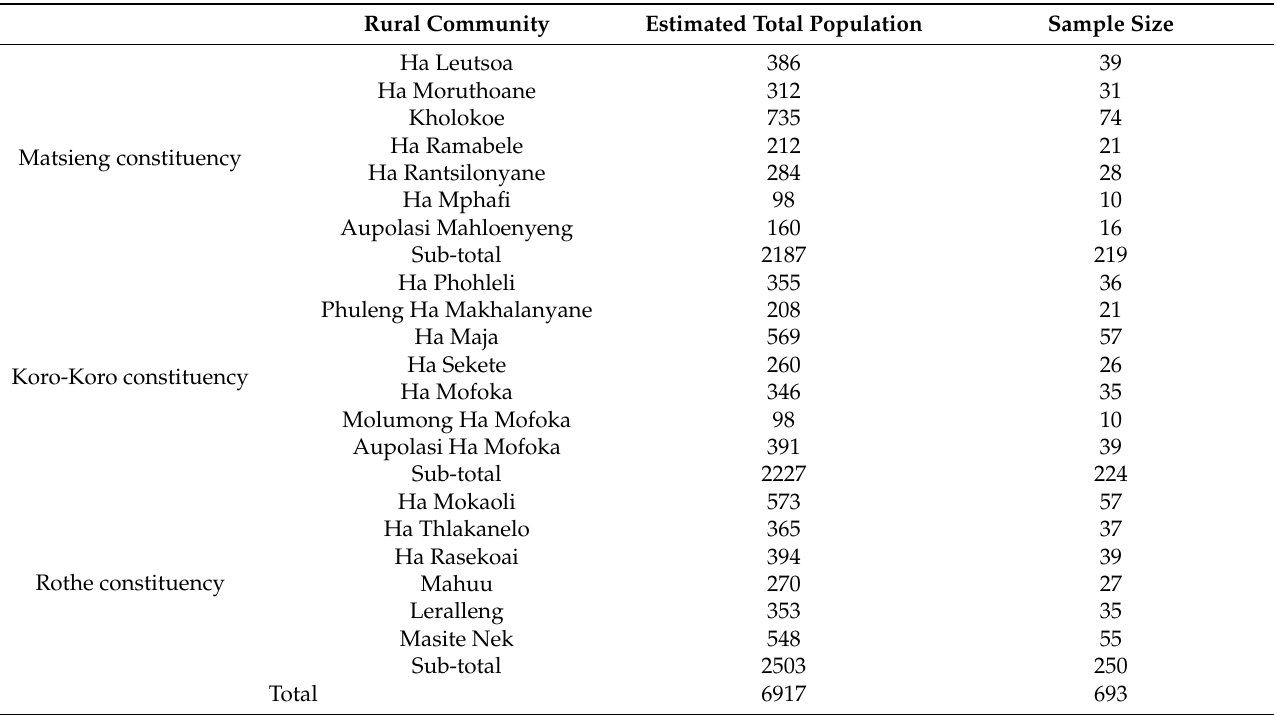
Table 2. Summary data on the estimated population and sample size of the communities in rural areas of Maseru that were studied. Rural Community Estimated Total Population Sample Size